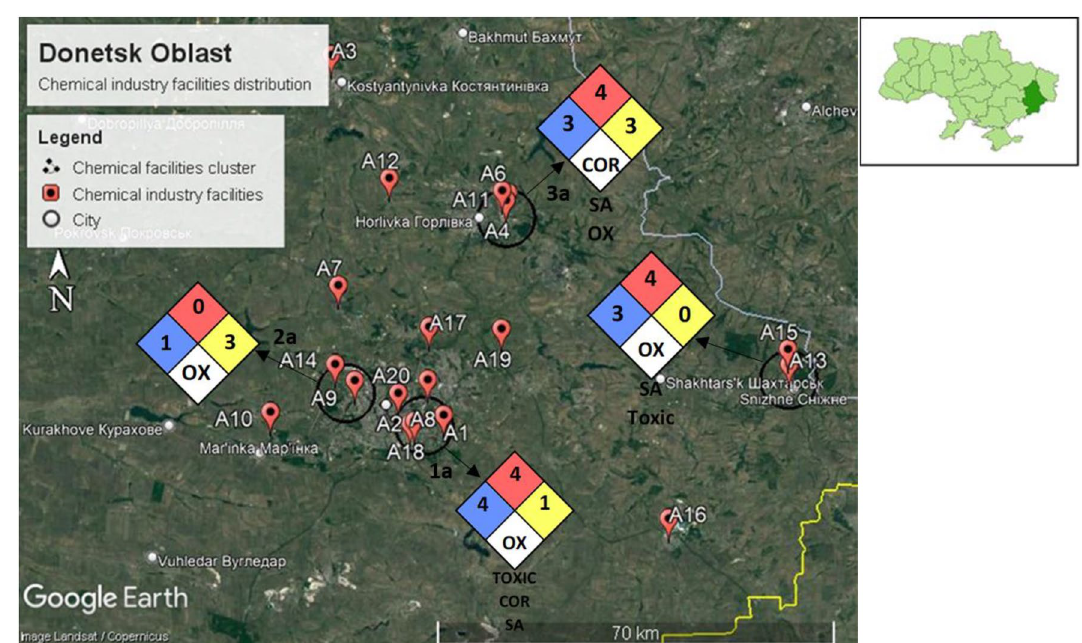
Figure 10. Chemical facilities cluster in Donetsk Oblast with NFPA hazard diamond assigned to each cluster.